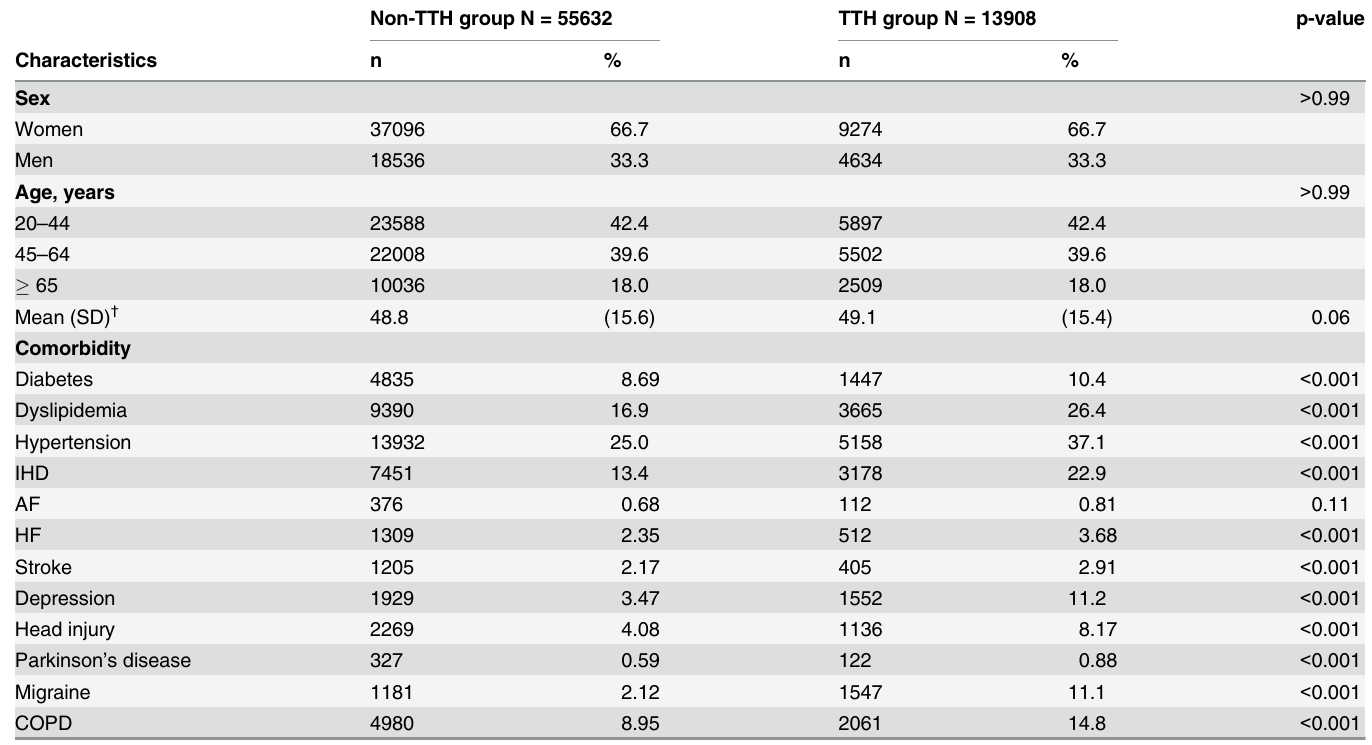
Table 1. Baseline demographic factors and comorbidity of study participants according to tension-type headache status. Non-TTH group N = 55632 TTH group N = 13908